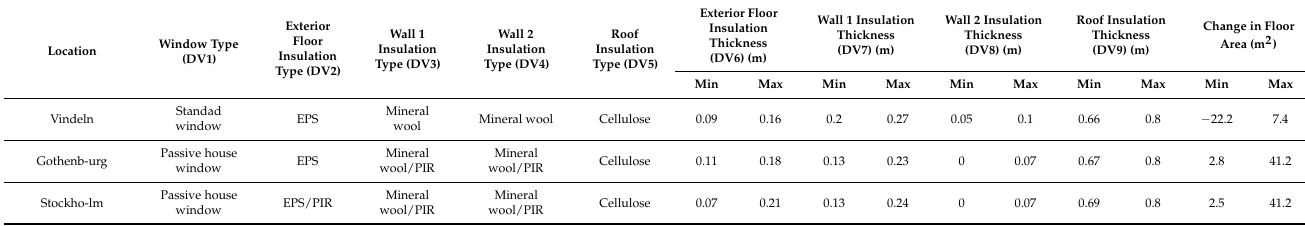
Table 6. Combination and variation of the design variables related to the passive energy efficiency measures that provide desirable Pareto solutions in different